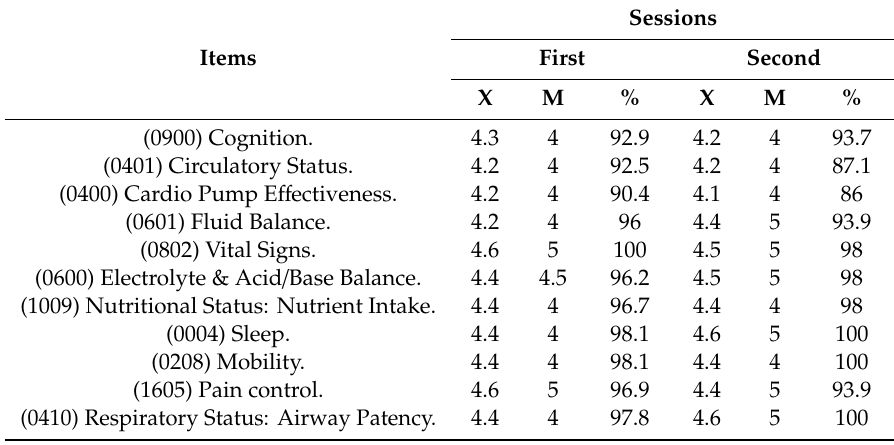
Table 3. Nursing Outcome Classifications (NOC) results result of the first and second session. Sessions Items First Second X M % X M % (0900) Cognition.